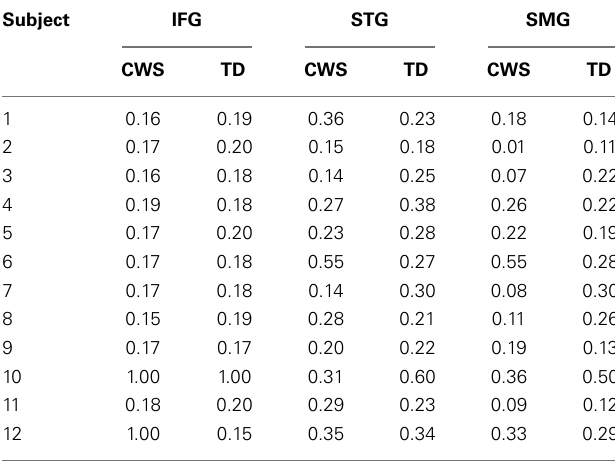
Table 3 | Laterality indices (LI) for all subjects (CWS andTD) across three ROIs .